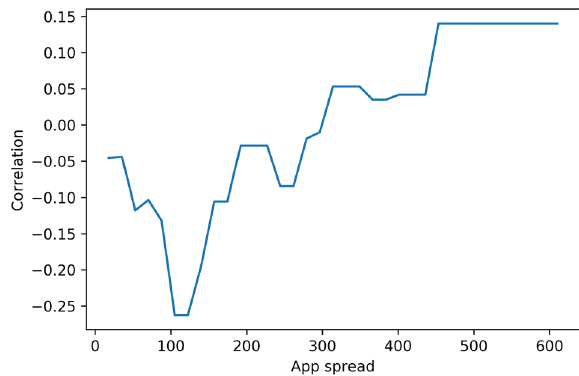
Fig. 2 Correlation between troll coef fi cients and average number of days for apps with different time